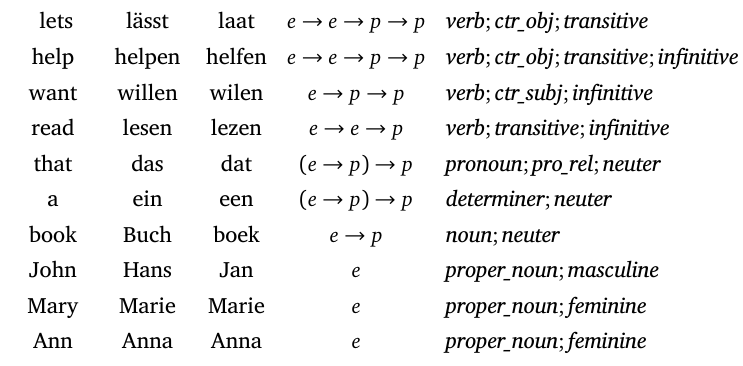
English German Dutch Semantic type vocabulary